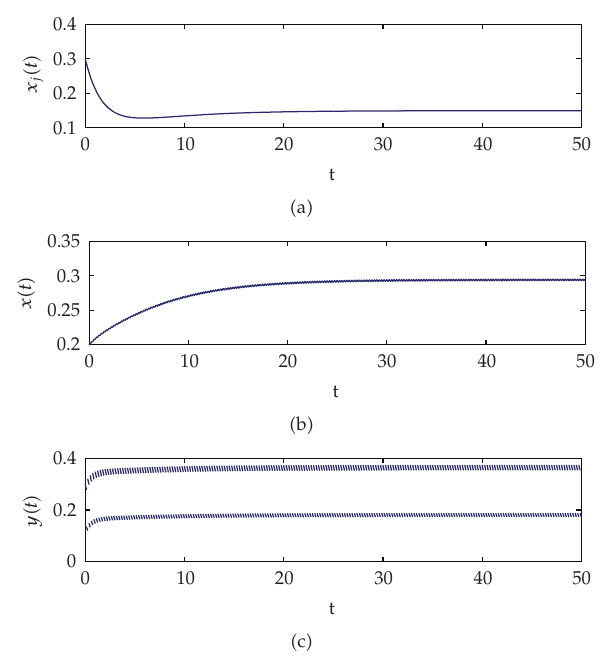
Figure 5: Time series of system (cid:3) 2.4 (cid:4) with parameters d (cid:8) 0 . 6; d 1 (cid:8) 0 . 4; α (cid:8) 0 . 8; τ (cid:8) 0 . 8; d 2 (cid:8) 0 . 5; β (cid:8) 0 . 8; λ (cid:8) 0 . 9; p (cid:8) 0 . 3; μ (cid:8) 0 . 2; T (cid:8) 0 .